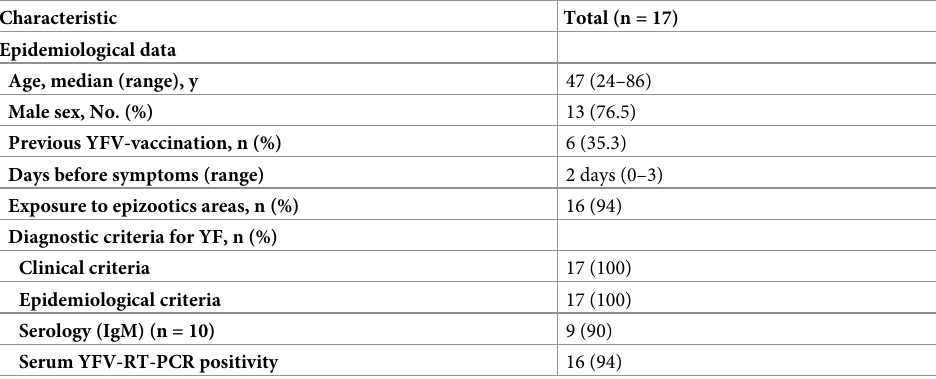
Table 1. Epidemiological, clinical and laboratorial characteristics of 17 patients with confirmed yellow fever.